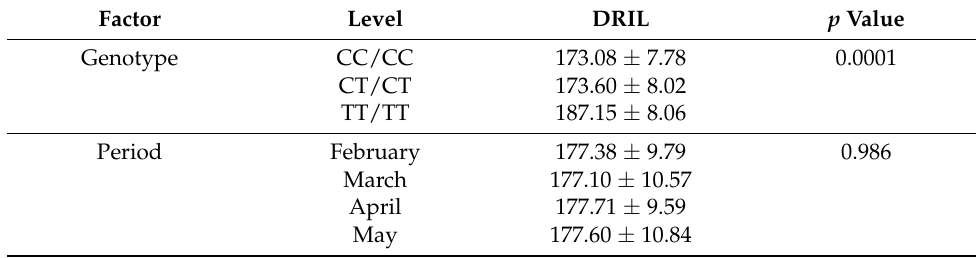
Table 4. Least square means ± SEM of DRIL and p -value for distance in days from ram introduction to lambing (DRIL) of each level of the fixed effects (genotype, period of ram introduction and their